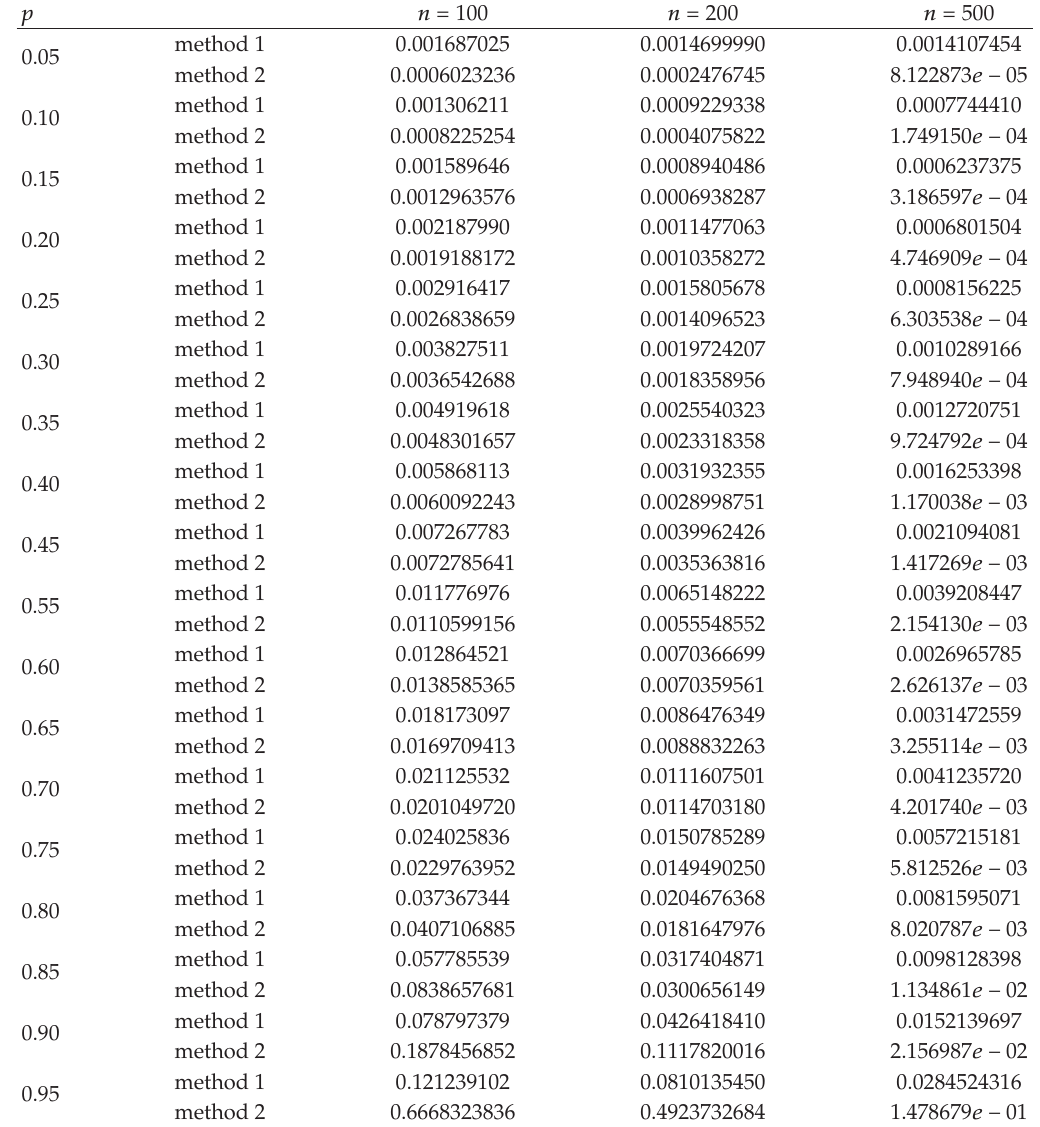
Table 2: Mean squared errors results for bandwidth selection methods for di ff erent sample sizes and for data from an exponential